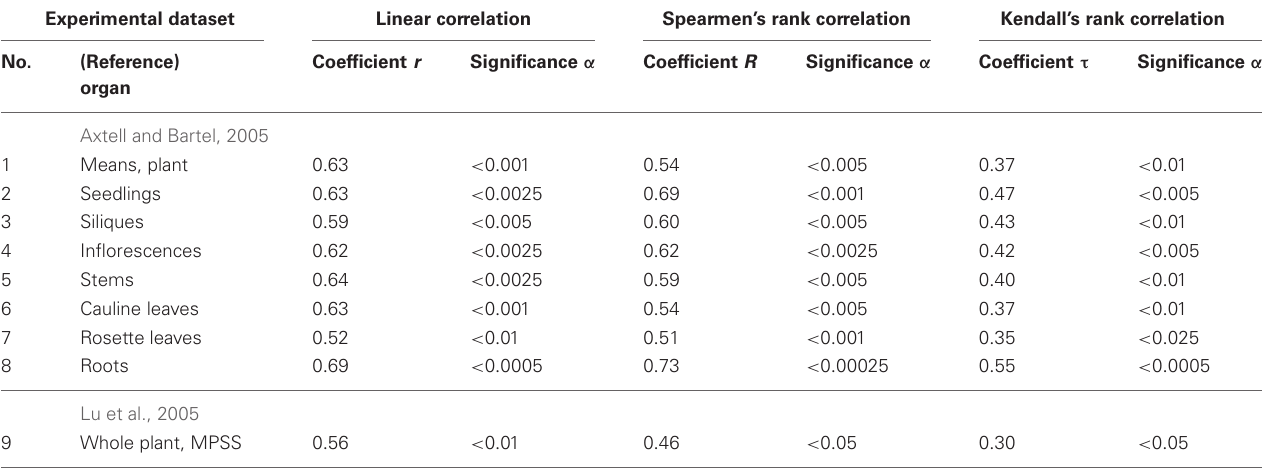
Table 3 | Twenty-seven correlations in Arabidopsis (Figure 4) between the miRNA abundance estimated by Equation (3) and those measured